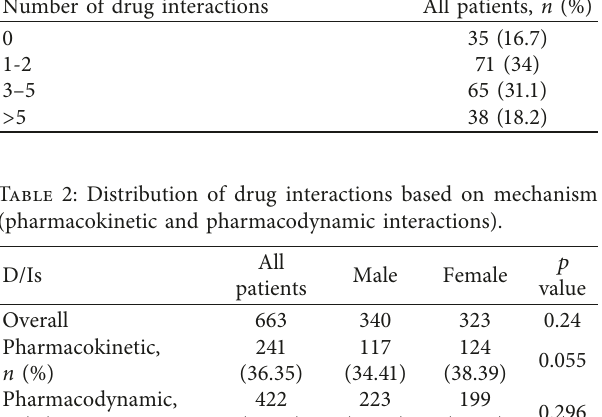
Table 3: Distribution of drug interactions based on risk category. Risk category of D/Is